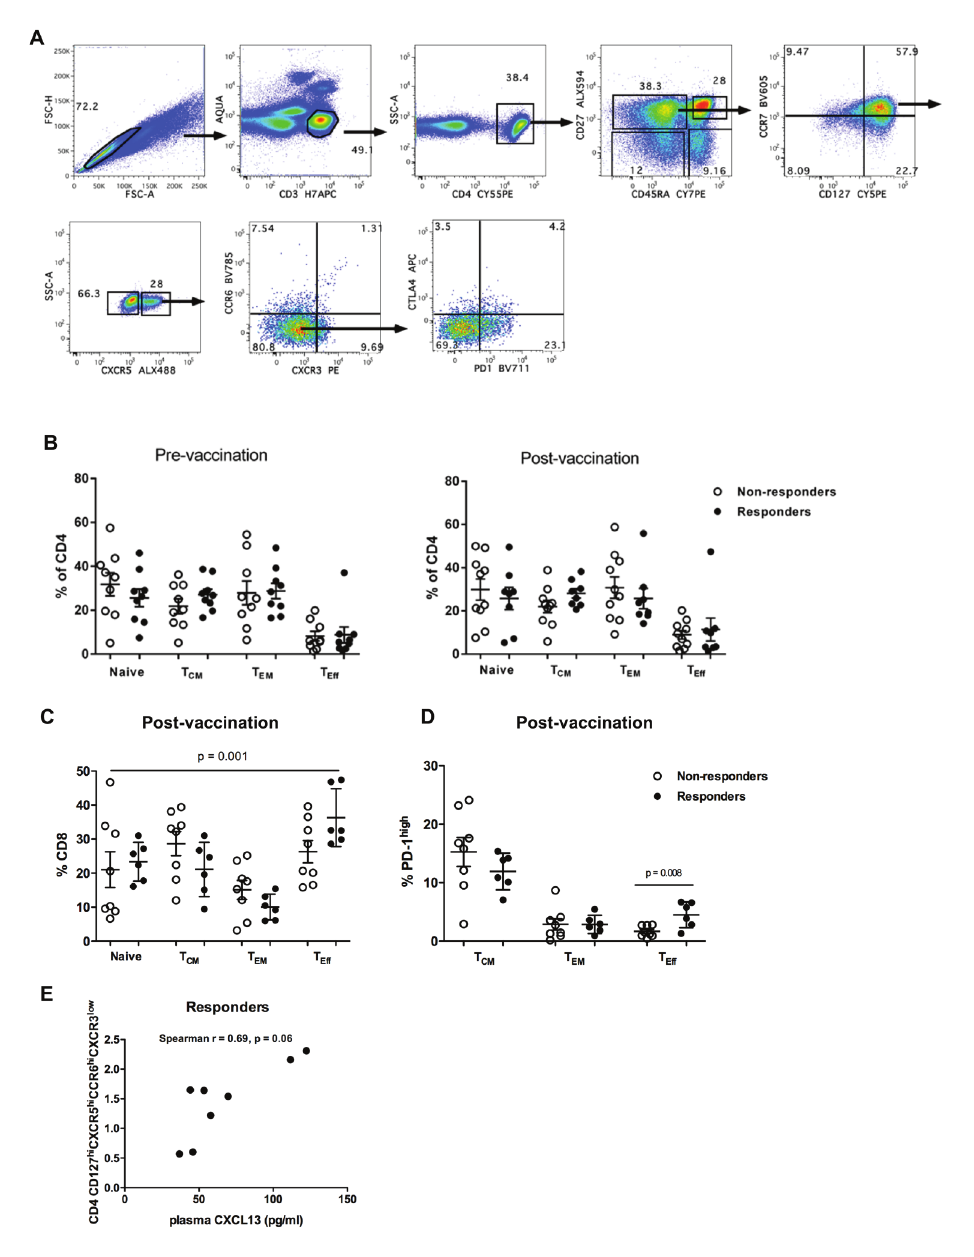
Supplementary Figure 3. (A) Gating scheme for phenotypic analysis of CD4 and CD8 populations, (B) Pooled data showing the relative frequencies of CD4 memory subsets, judged by the expression of CD27 and CD45RA, (C) Pooled data showing the relative frequencies of CD8 memory subsets, judged by the expression of CD27 and CD45RA, (D) the frequency of PD-1 high CD8 T cells in memory compartments post-vaccination is shown, (E) Correlation between CCR6 high pTfh cells and plasma levels of CXCL-13 in responders post-vaccination. Data are comparison scatterplots with mean and SEM. P-values calculated using the Mann-Whitney U test (C) or Spearman rank correlation test